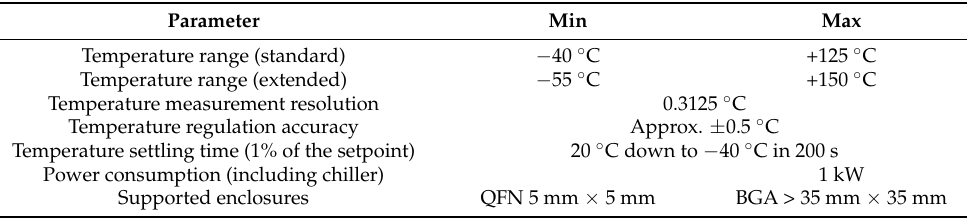
Table 1. Key parameters of the presented solution. Parameter Min